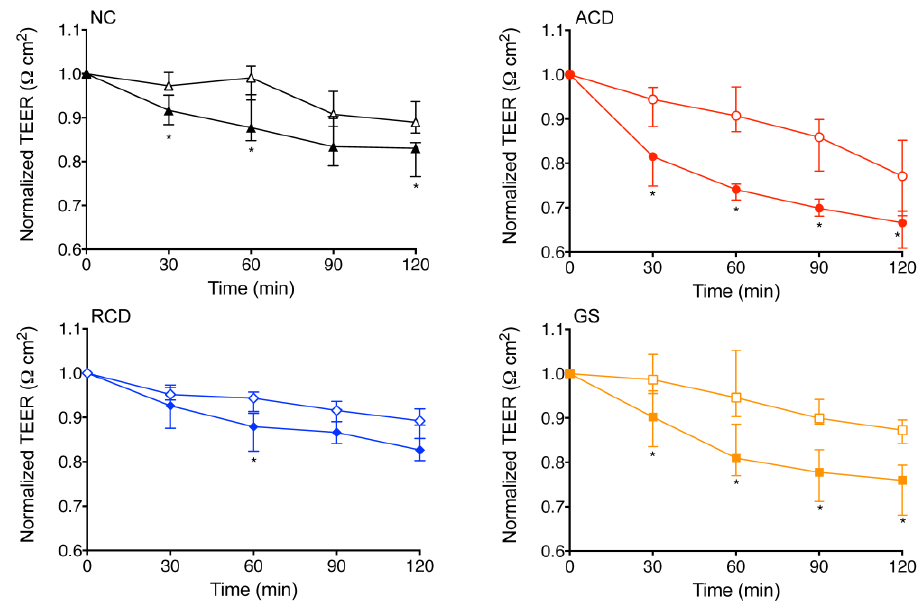
Figure 1. Normalized transepithelial electrical resistance (TEER) changes in human intestinal explants exposed to PT-gliadin or media alone. Explants obtained from non-celiac controls (NC), celiac patients with active disease (ACD), celiac patients in remission (RCD), and non-celiac patients with gluten sensitivity (GS). Explants were exposed to media alone (open symbols) or to PT-gliadin (filled symbols). NC (black triangle) explants demonstrated a greater increase in permeability (decrease in TEER) when exposed to PT-gliadin vs. exposure to media alone at 30, 60 and 120 min. RCD (blue diamond) explants demonstrated a greater increase in permeability when exposed to PT-gliadin vs exposure to media alone at 60 and 120 min. ACD (red circle) and GS (gold square) explants demonstrated a greater increase in permeability when exposed to PT-gliadin vs exposure to media alone at 30, 60, 90 and 120 min. Symbol denotes the median. Whiskers denote the 25th to 75th percentile. * p <